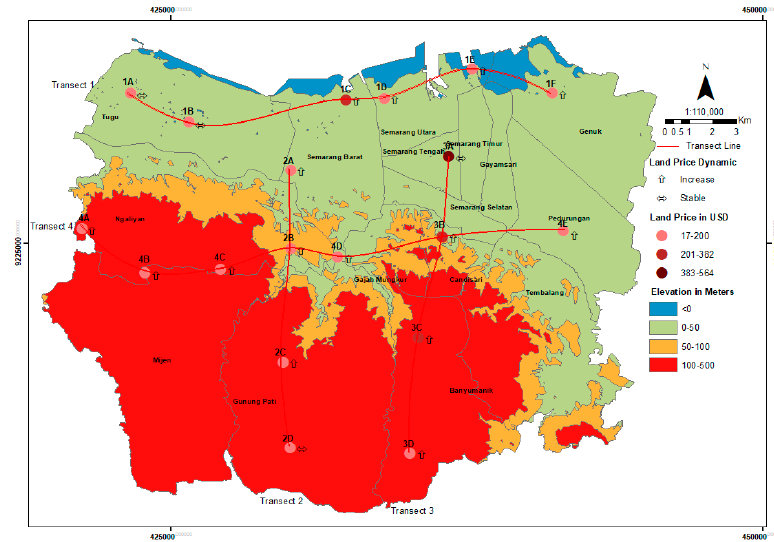
Figure 6. Land value distribution in different elevations.